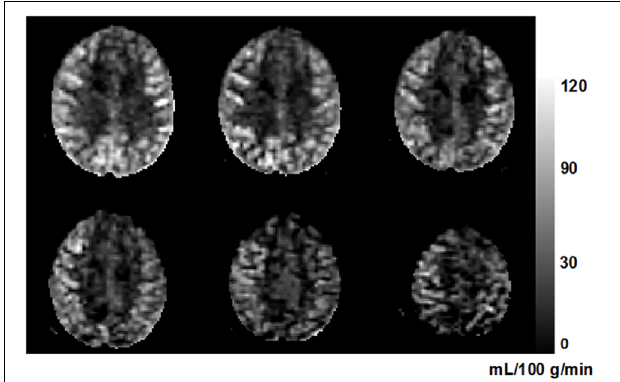
FIGURE 2 | An example perfusion image from a 63-year-old subject. Six axial slices are shown from inferior (top left) to superior (bottom right). The higher perfusion in gray matter compared to that in white matter can be clearly seen. The unit of the gray-scale bar is mL/100g/min.